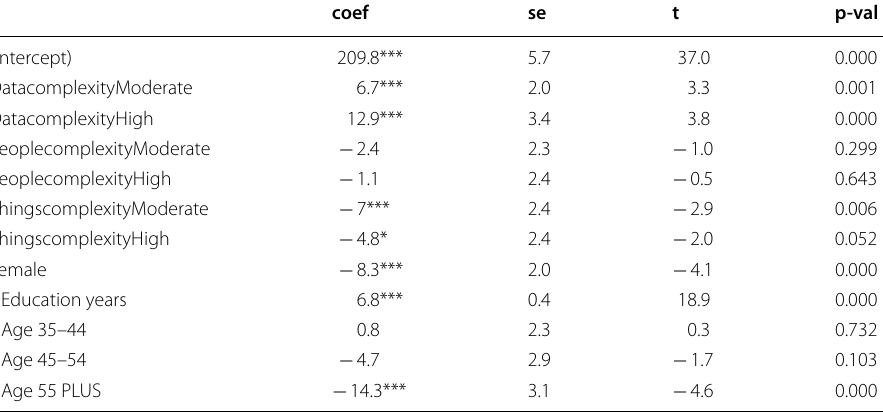
Table 16 Regression results for Japan. Source: PIAAC 2012, DOT index, ISCO-08 codes